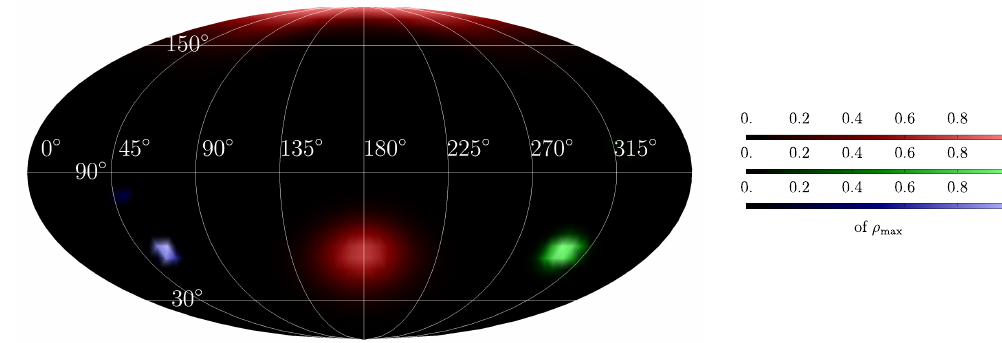
(cid:16) (cid:17) k i ,k f , ϑ , ϕ . The longitude